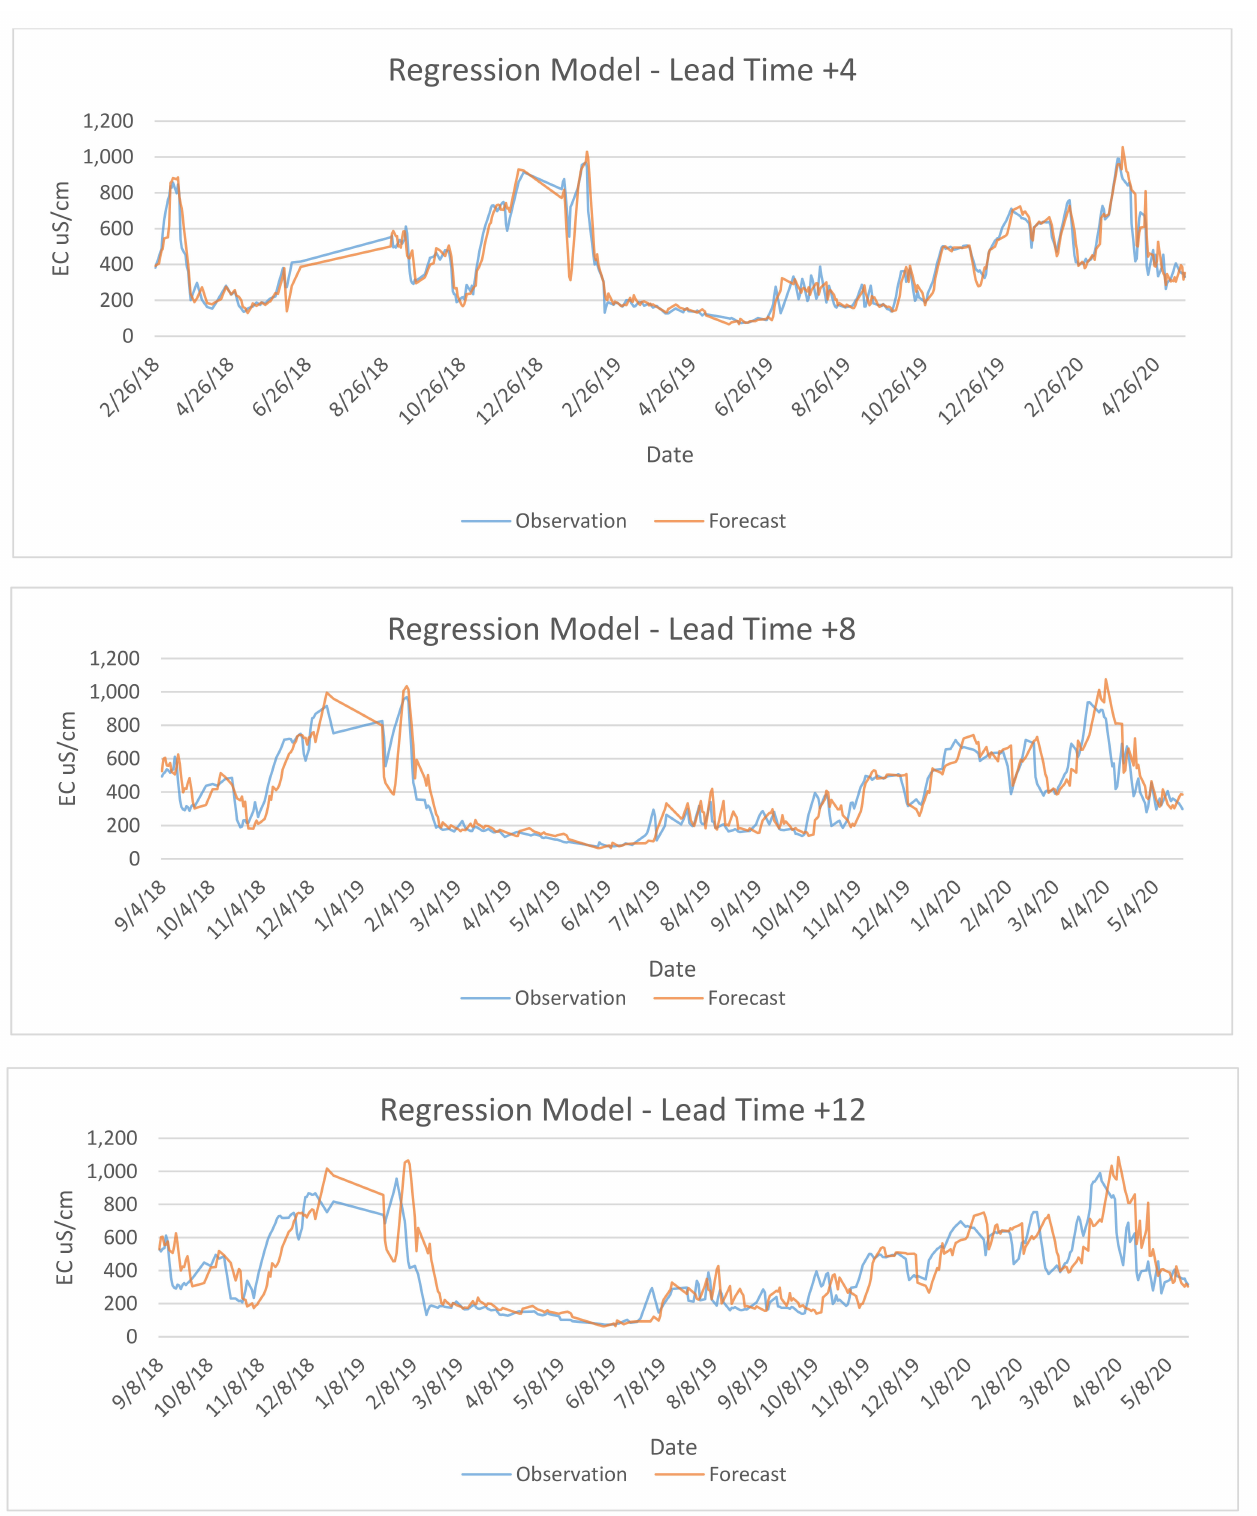
Figure 11. Comparison of Regression model forecasts and observations of EC at various lead times for the period